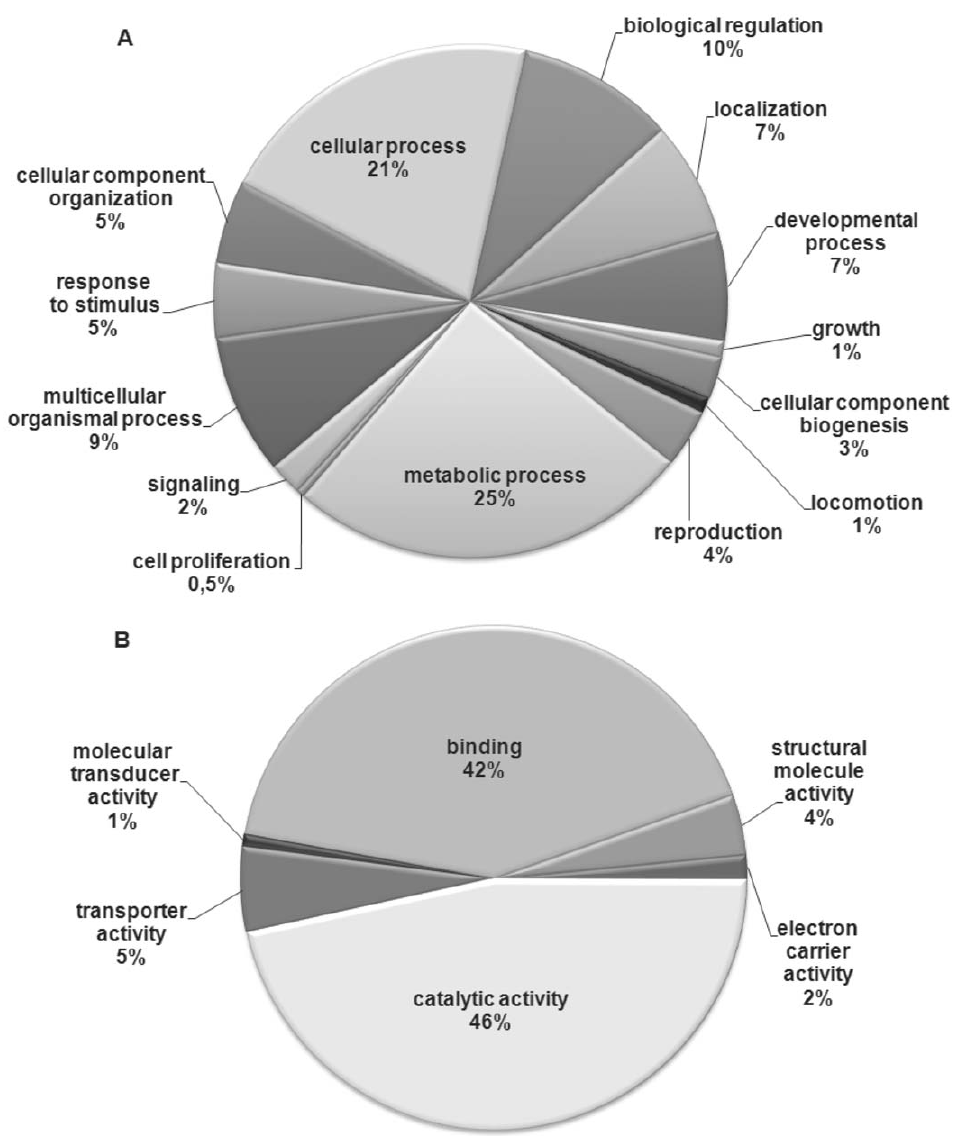
Figure 3. Distribution of GO IDs at the 2 nd level. Based on their participation in biological processes (A) and molecular functions (B) of up- regulated ESTs (putative proteins) in a sensitive genotype (S) of Myzus persicae treated with pirimicarb. Out of 97 annotated EST sequences, 69 presented GO IDs for biological processes and 88 for molecular functions.